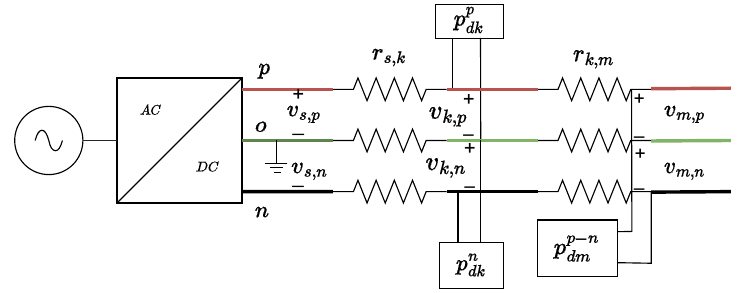
Figure 1. Schematic representation of a bipolar DC